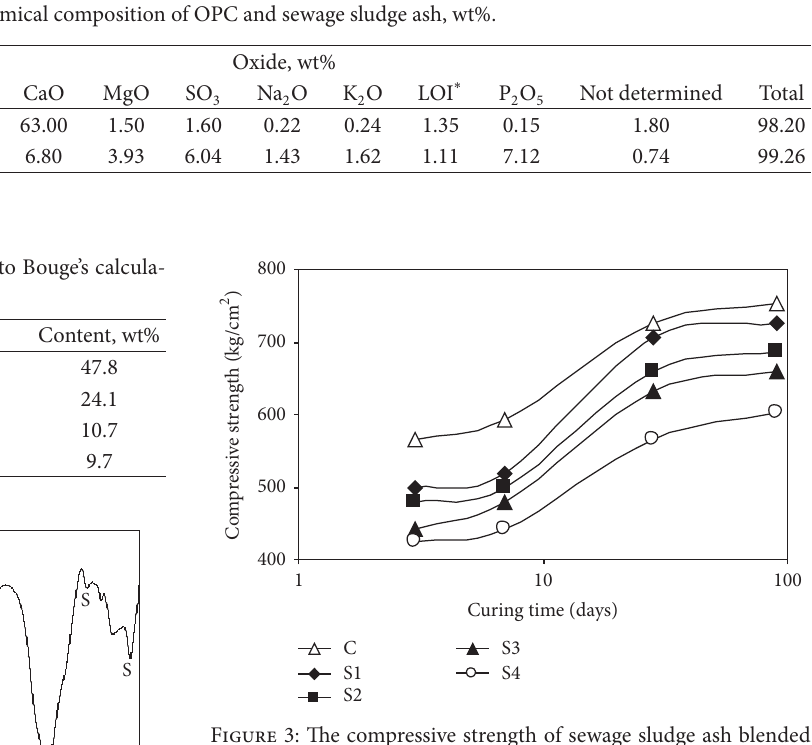
T 2: Chemical composition of OPC and sewage sludge ash, wt